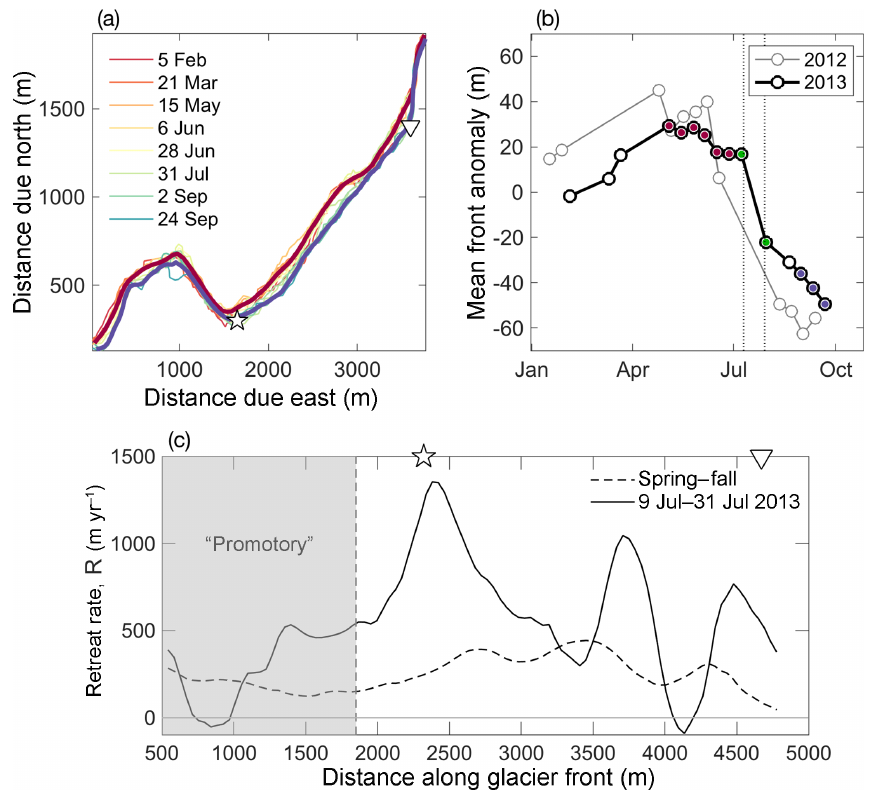
Figure 4. Seasonal advance and retreat of glacier front. (a) The total 15 front profiles acquired from February to September 2013; the legend lists every second profile. The thick red and blue profiles represent the May–June and September averages, respectively. Also indicated are the locations of the two plumes ( , (cid:79) ). (b) Mean front position, shown as an anomaly from the yearly mean position. The 2012 values are shown in gray and 2013 in black. The 2013 spring profiles used in (a) are highlighted in red, fall profiles in blue, and July profiles in green. The vertical dotted lines demarcate the period from 12 to 31 July during which calving was observed. (c) Retreat rates, R(x) , along the glacier front. Positive R represents glacier retreat and negative R glacier advance. The dashed line represents the spring–fall 2013 mean retreat rates; the solid line shows the retreat rates between 9 and 31 July, computed from the profiles marked green in (b)